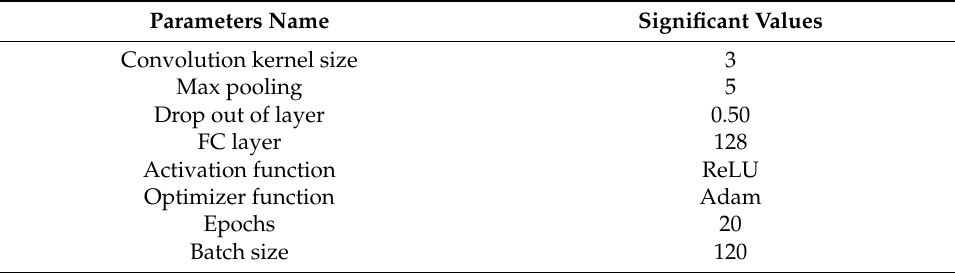
Figure 8. Architecture CNN-LSTM model. Table 2. Parameter values of the CNN-LSTM